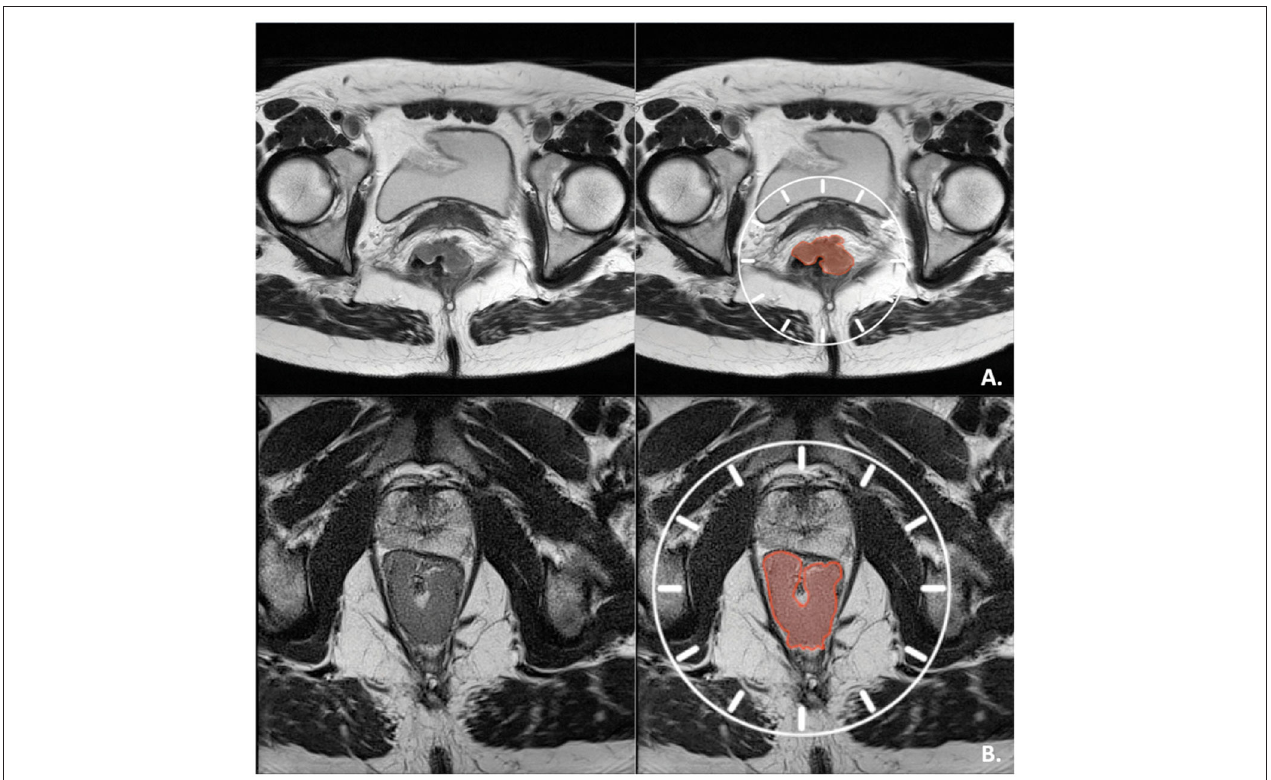
FIGURE 2 | Tumor orientation. (A) Axial T2-weighted view of an anterior mrT3 tumor with center and invasive component between 11 and 1 o’clock. (B) Axial T2-weighted view of a non-anterior, early mrT3 tumor with center and invasive component between 5 and 7 o’clock.